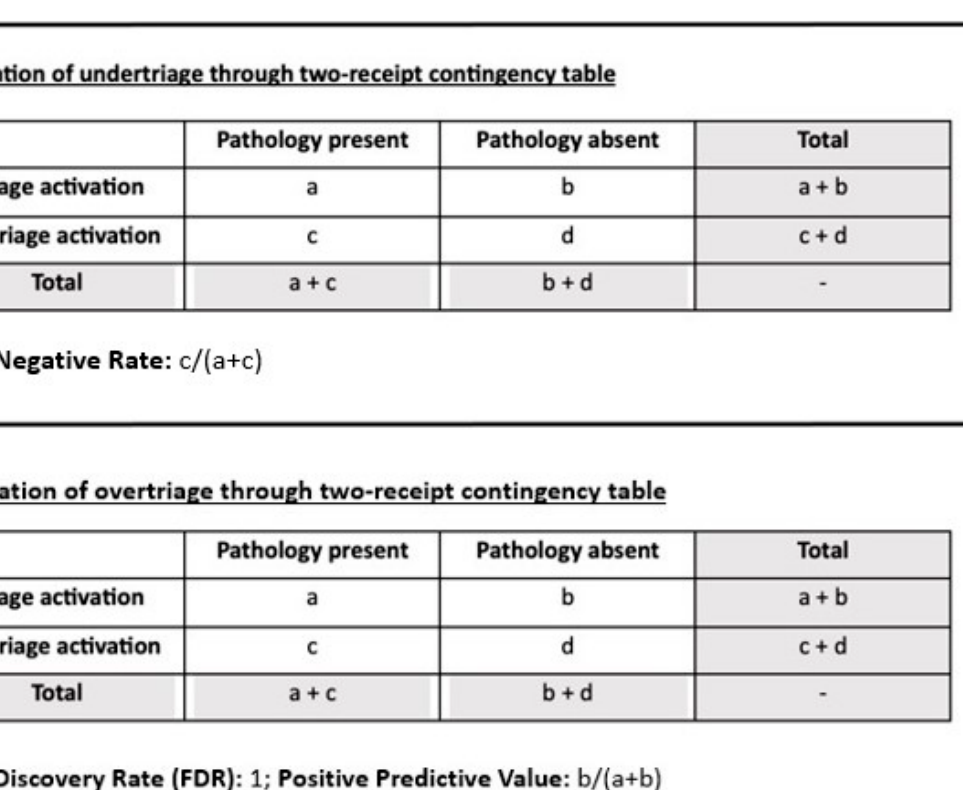
Figure 3. Calculation of UT and